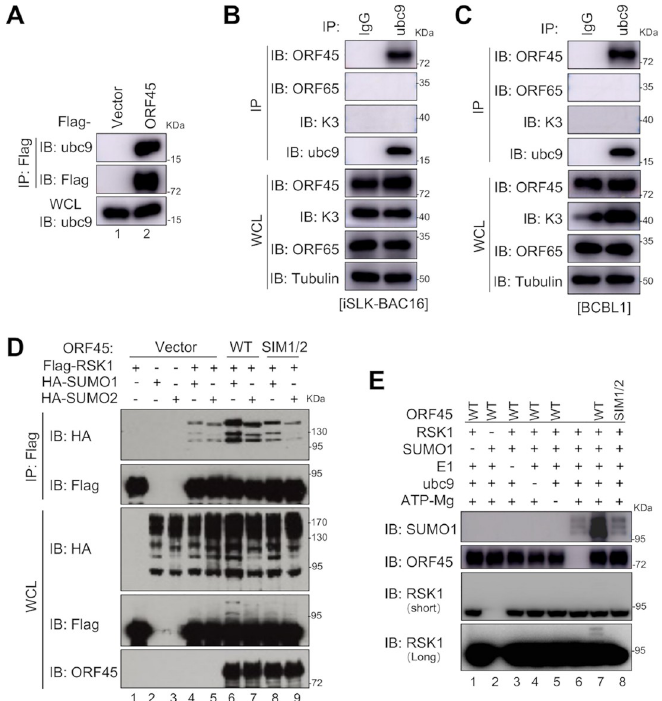
Fig 3. KSHV ORF45 acts as a SIM-dependent SUMO E3 ligase for RSK1. ( A ) KSHV ORF45 binds to endogenous ubc9. HEK293T cells were transfected with Flag-tagged ORF45 or vector control and cell lysates were subjected to IP and IB with indicated antibodies at 48 h post-transfection. ( B-C ) KSHV ORF45 binds to endogenous ubc9 during KSHV lytic replication. iSLK-BAC16 (B) and BCBL1 (C) cells were treated with doxycycline/sodium butyrate or TPA to induce KSHV lytic replication, respectively. Cell lysates were subjected to IP and IB with indicated antibodies at 72 h post-induction. ( D ) KSHV ORF45 enhances RSK1 SUMOylation via SIM1/2 in cells. HEK293T cells were transfected with indicated plasmids and cell lysates were subjected to denatured IP and IB with indicated antibodies at 48 h post- transfection. ( E ) KSHV ORF45 enhances RSK1 SUMOylation via SIM1/2 in vitro . Recombinant RSK1 was incubated with SAE1/UBA2 (E1), Ubc9 (E2), SUMO1, ATP/Mg, and ORF45 or ORF45 SIM1/2 in SUMO reaction buffer. The SUMOylation of RSK1 was detected by indicated